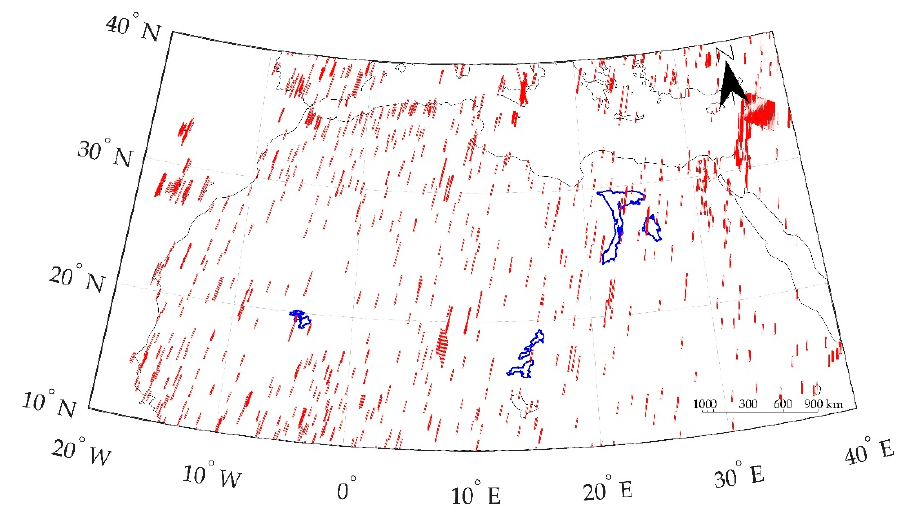
Figure 10. Cluster 13 Extent Across North Africa with Corresponding Hyperion Coverage.